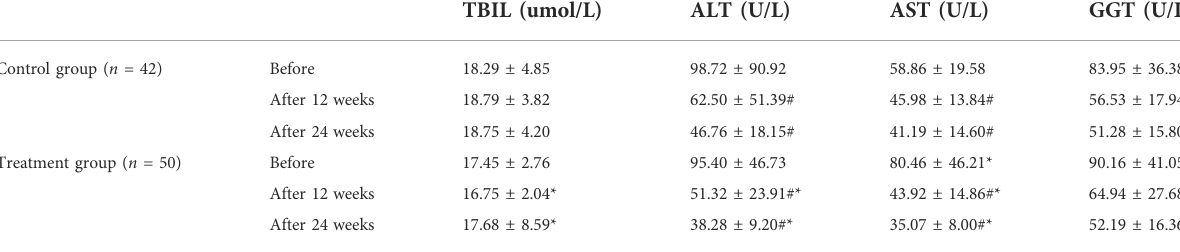
TABLE 2 Improvement of liver function at different time points before and after